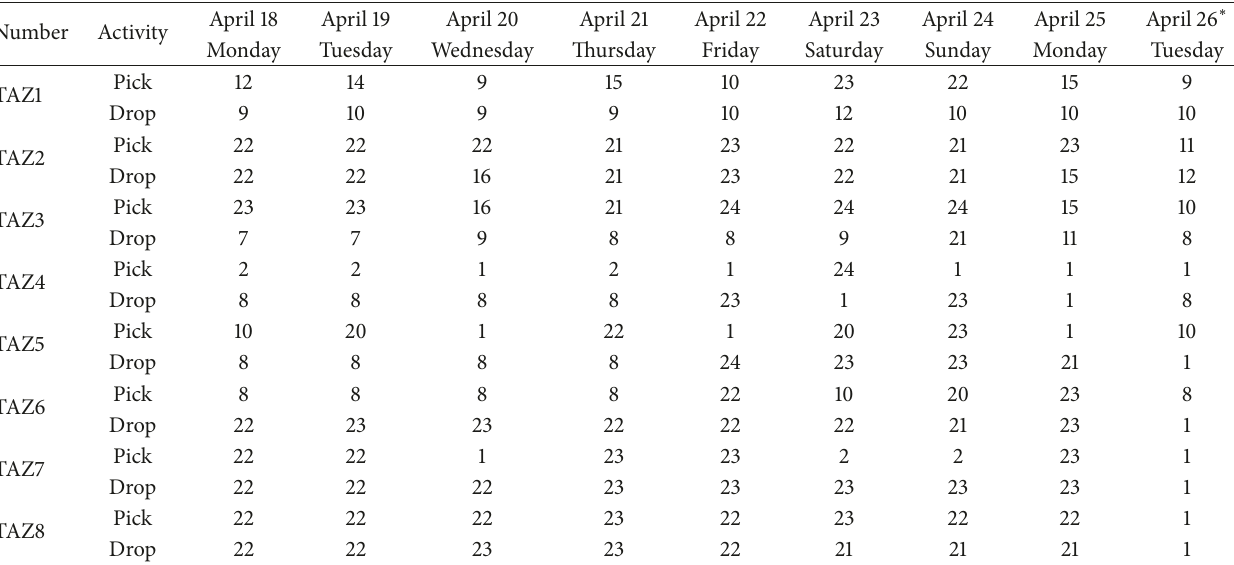
Table 3: Peak hour statistics of different